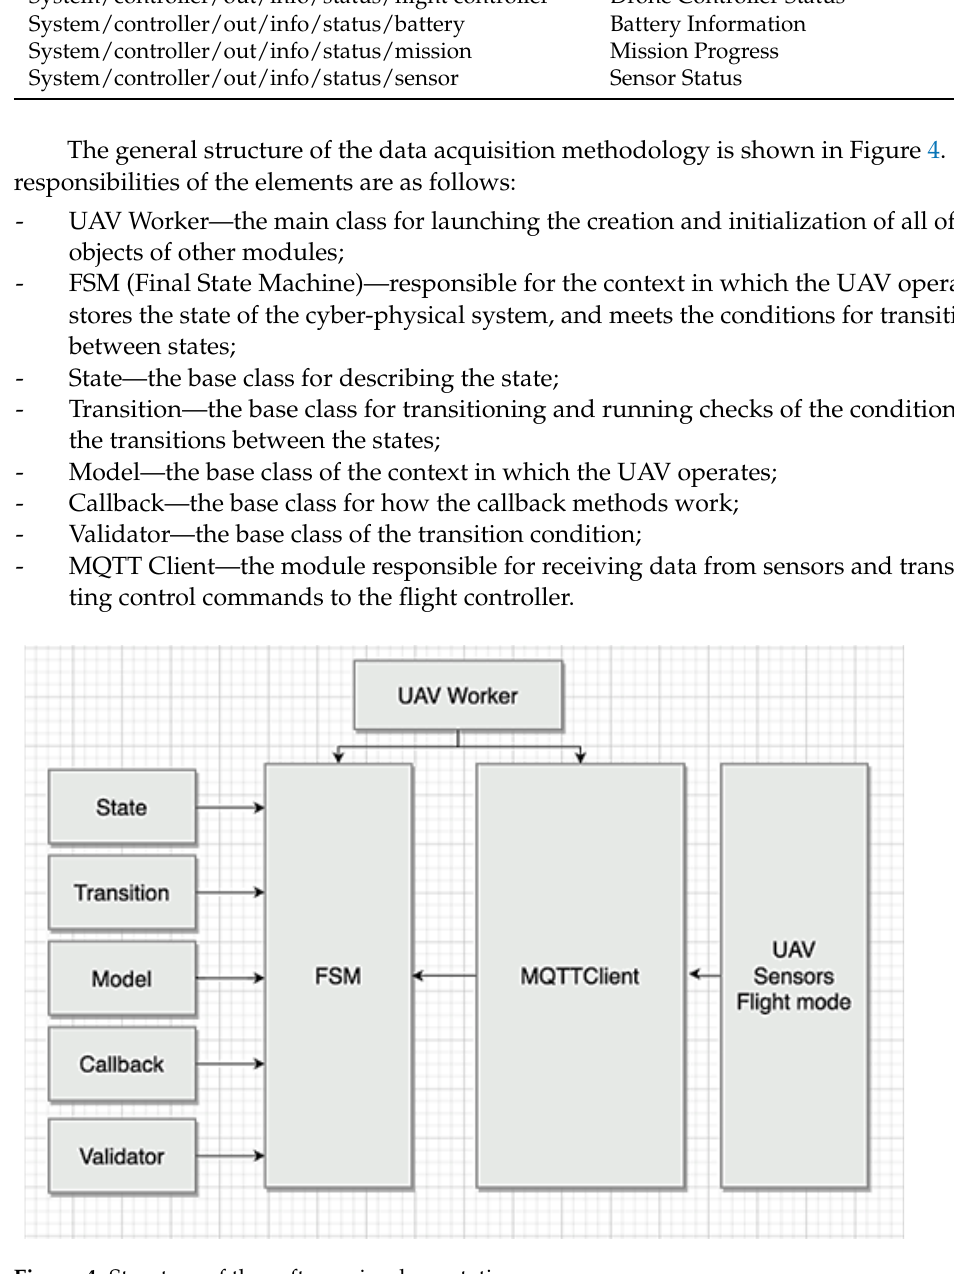
Figure 4. Structure of the software